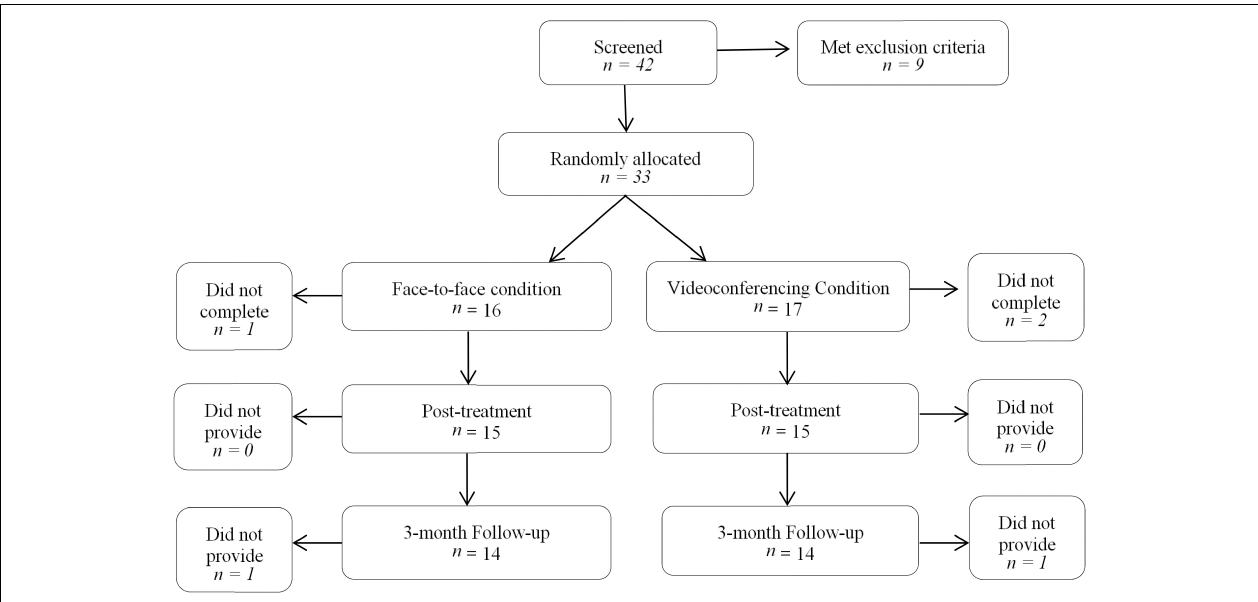
FIGURE 1 | Participant flowchart. n , number of couples.